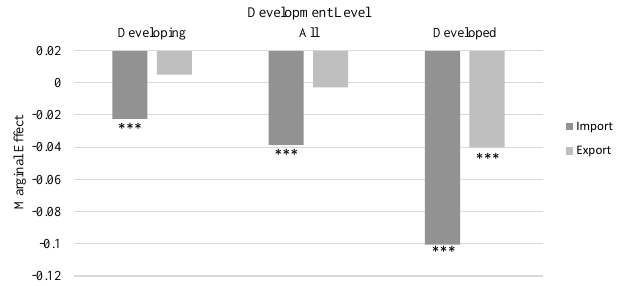
Figure 2. Marginal effects of natural disasters in partner countries on China’s bilateral trade versus development levels. ∗ / ∗∗ / ∗∗∗ indi- cates significance at 0.1/0.05/0.01